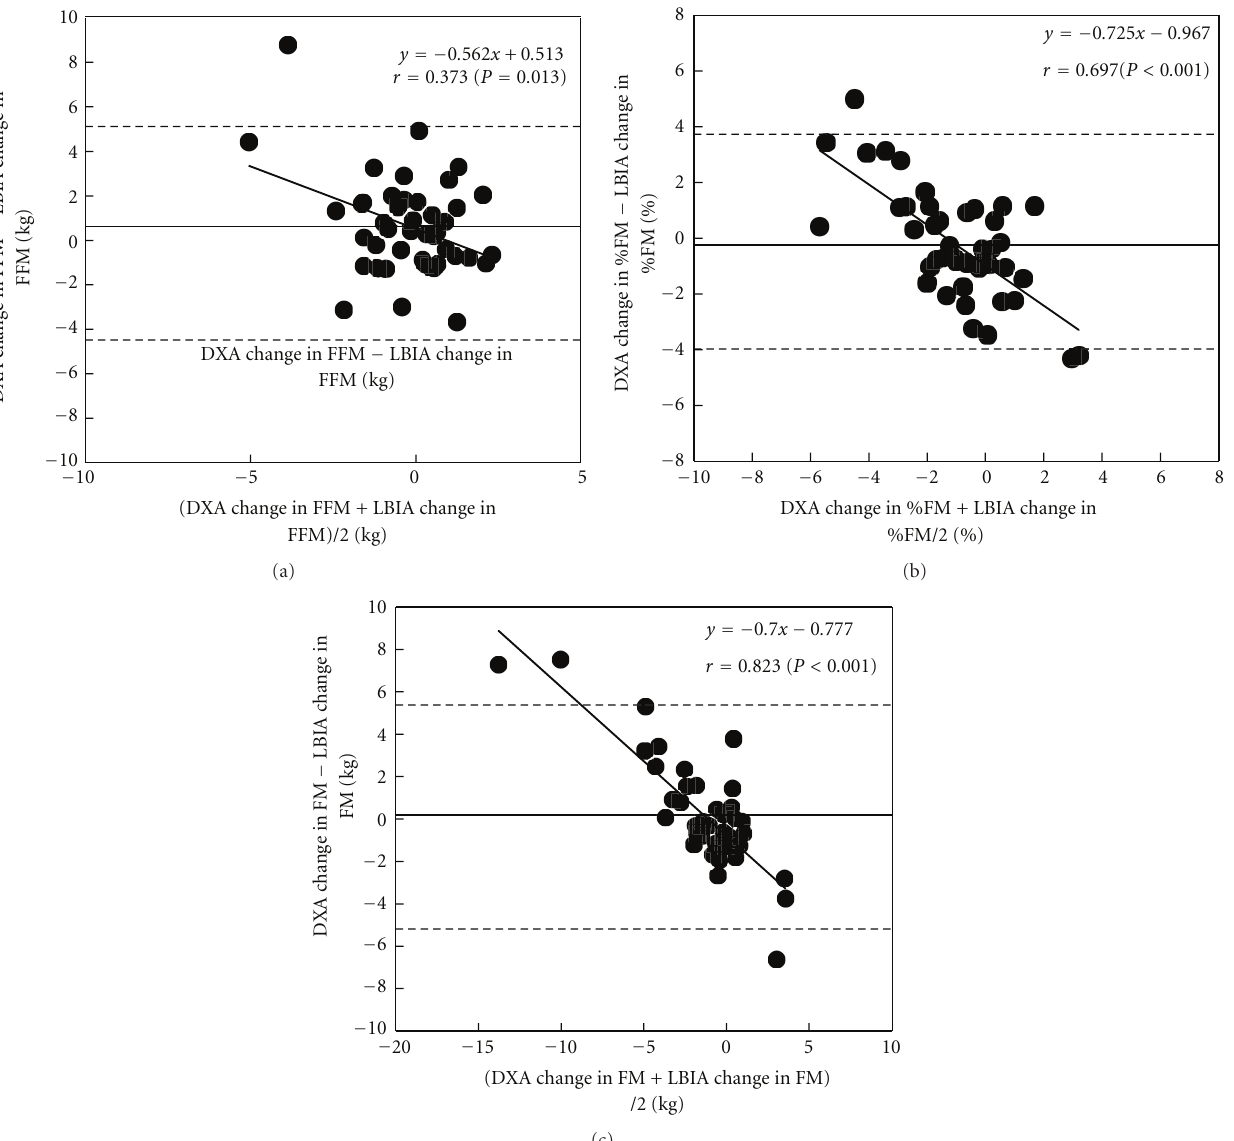
Figure 4: Bland-Altman plots comparing LBIA with DXA for changes in the FFM (a), %FM (b), and FM (c) after intervention. DXA: dual X-ray absorptiometry; LBIA: leg-to-leg bioelectrical impedance analysis; FFM: fat free mass; %FM: percentage body fat; FM: fat mass. The middle solid line represents the mean di ff erence between LBIA and DXA; the upper and lower dotted lines represent 95% limits of